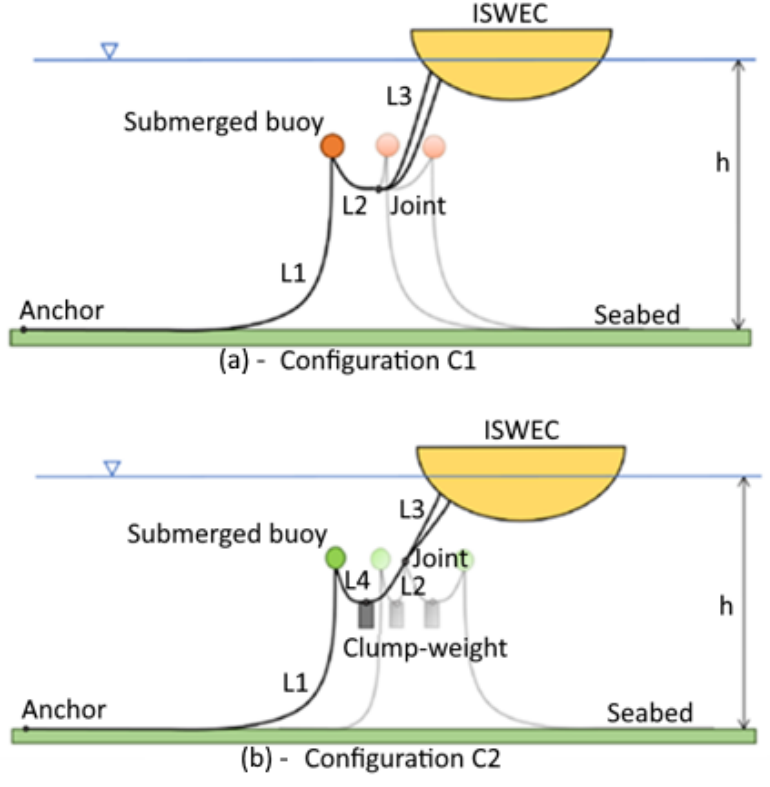
Figure 3. ISWEC mooring layouts: ( a ) C1; ( b )